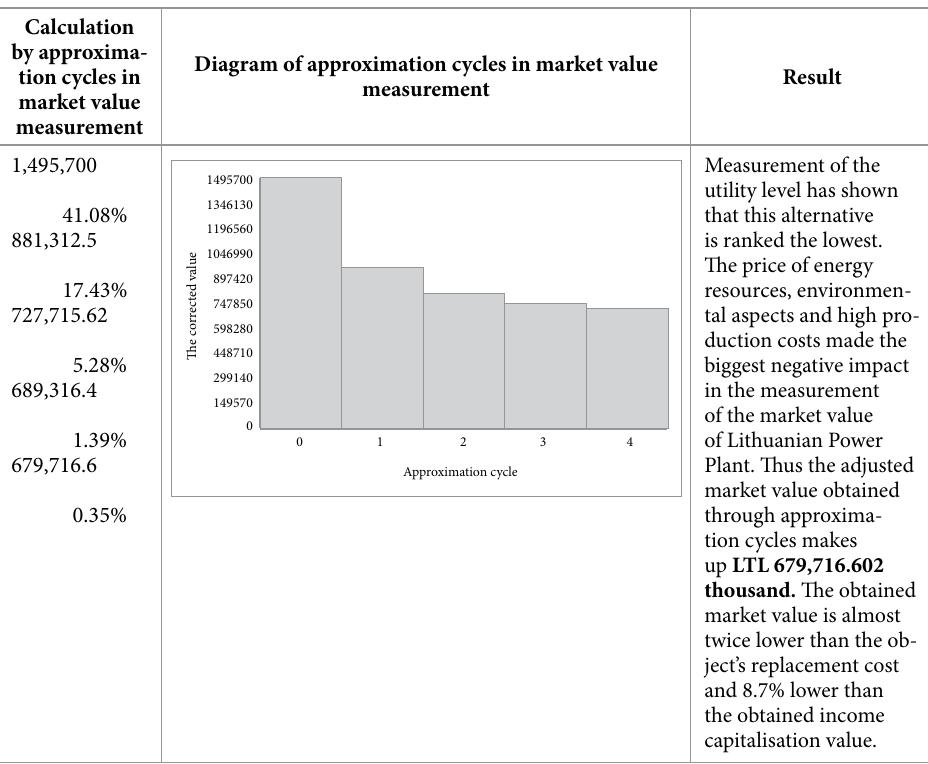
table 9. The result of market value measurement for Lithuanian Power Plant calculation by approxima­ diagram of approximation cycles in market value tion cycles in market value measurement